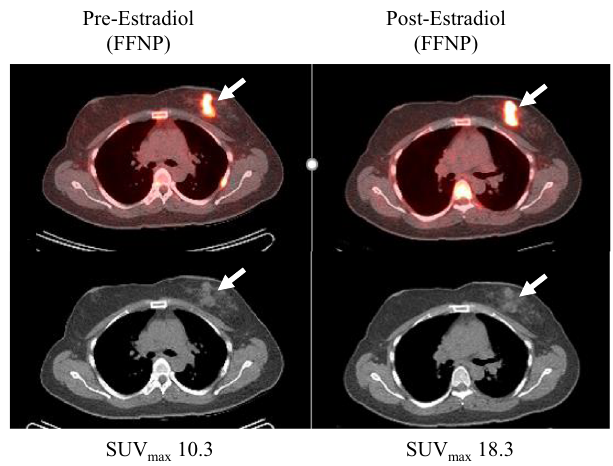
Fig. 1 Responder. A woman with newly diagnosed ER + /PR + /HER2 − invasive ductal carcinoma with metastatic disease at diagnosis in left axillary lymph nodes and a rib. She was treated with an aromatase inhibitor and palbociclib after the estradiol challenge test and had marked improvement of all lesions. Selected fused transaxial 21-[ 18 F] fl uorofuranyl- norprogesterone [FFNP]-PET/CT (top) and CT (bottom) images at baseline show intense FFNP uptake in the primary left breast cancer (arrows). One day after estradiol, tumor FFNP uptake measured as the maximum standardized uptake value (SUV max ) (arrows) was increased by 78% from baseline.